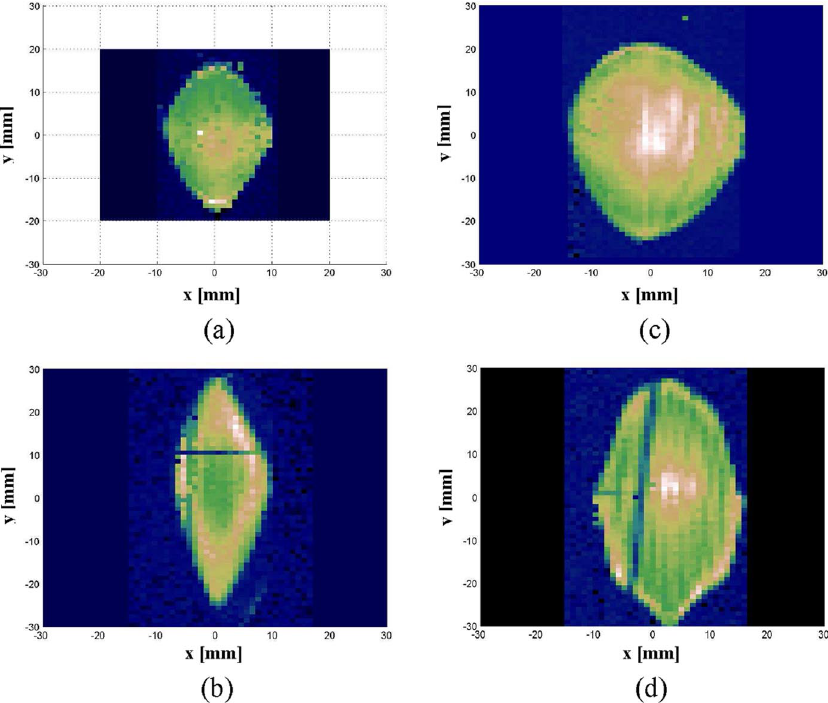
FIG. 19. (Color) Beam current density profiles J (cid:6) x; y (cid:7) measured with crossed slits. (a),(b) 60% fill factor case at QD1 and D2, ; (c),(d) 80% fill factor case at QD1 and D2, respectively, single respectively, single time slice ( ( t (cid:5) 0 : 12 (cid:2) s ) taken 2 : 64 (cid:2) s after * 0 . In (b) and (d) the dark crossed (or line) pattern that is seen comes from bridges time slice ( ( t (cid:5) 0 : 12 (cid:2) s ) taken 3 : 12 (cid:2) s after * 0 across the slits that are there to strengthen the slit structure and avoid